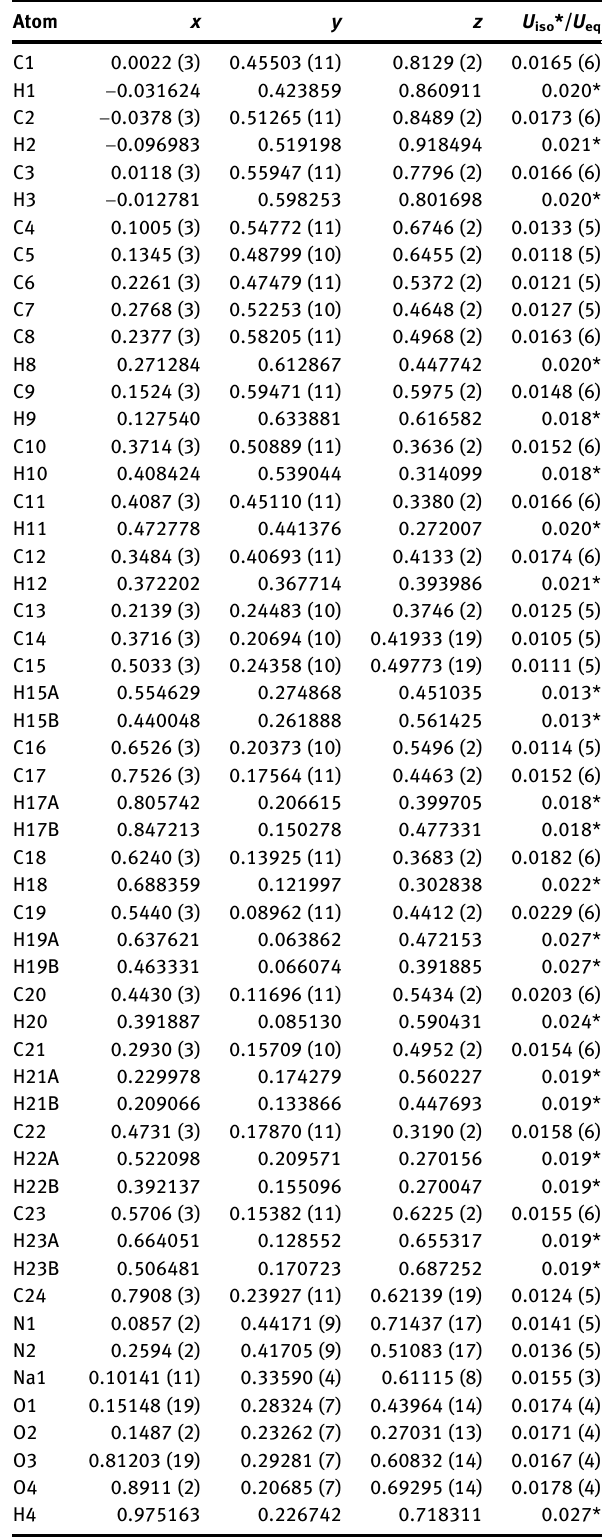
Table  : Fractional atomic coordinates and isotropic or equivalent isotropic displacement parameters (Å 